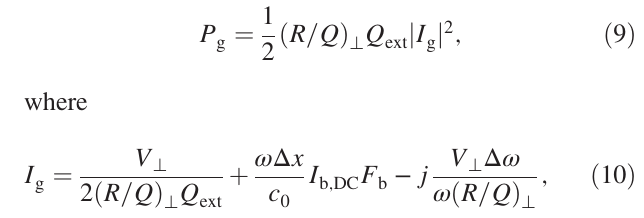
FIG. 11. Input rf power as a function of the external quality factor of the fundamental mode. The beam is offset in the deflecting direction by maximum (cid:2) 2 mm. The bunch form factor at 400 MHz is approximately 1 [3]. An LHC DC beam current of 0.58 A is assumed.